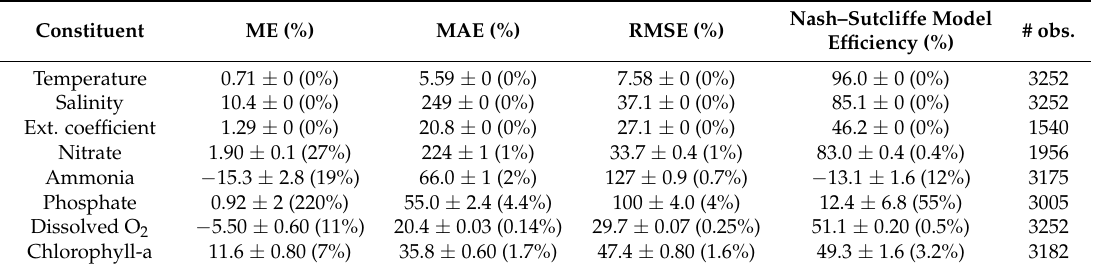
Table 4. Mean and standard deviation of calibration performance statistics across 27 runs.